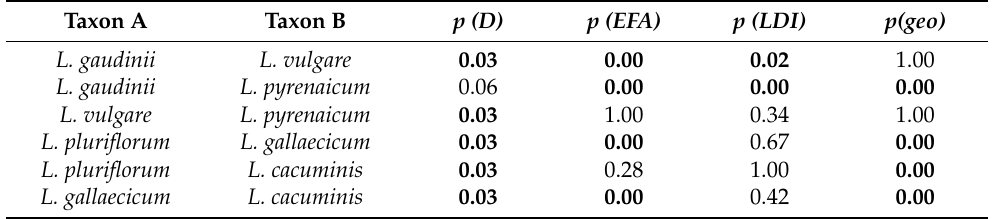
Table 1. Significance table for the pairwise comparisons in the L. pluriflorum - and L. vulgare -groups, with p -values for the environmental niche-overlap metric D, the permutation tests of the elliptic Fourier analysis ( EFA ), the Welch’s tests of the leaf-dissection index ( LDI ), and the permutation test of the geographical overlap ( geo ). In all cases, the p -values were Bonferroni-corrected. Corrected p - values greater than 1.0 are truncated to 1.0. Bold numbers indicate significant p -values.